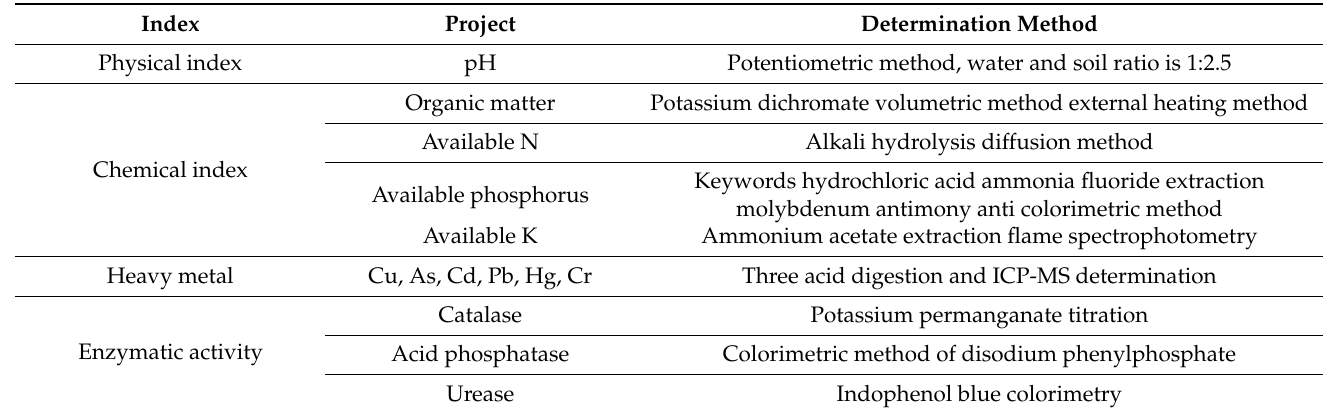
Table 2. Analysis and test methods of soil physical and chemical indexes, heavy metal elements and enzyme